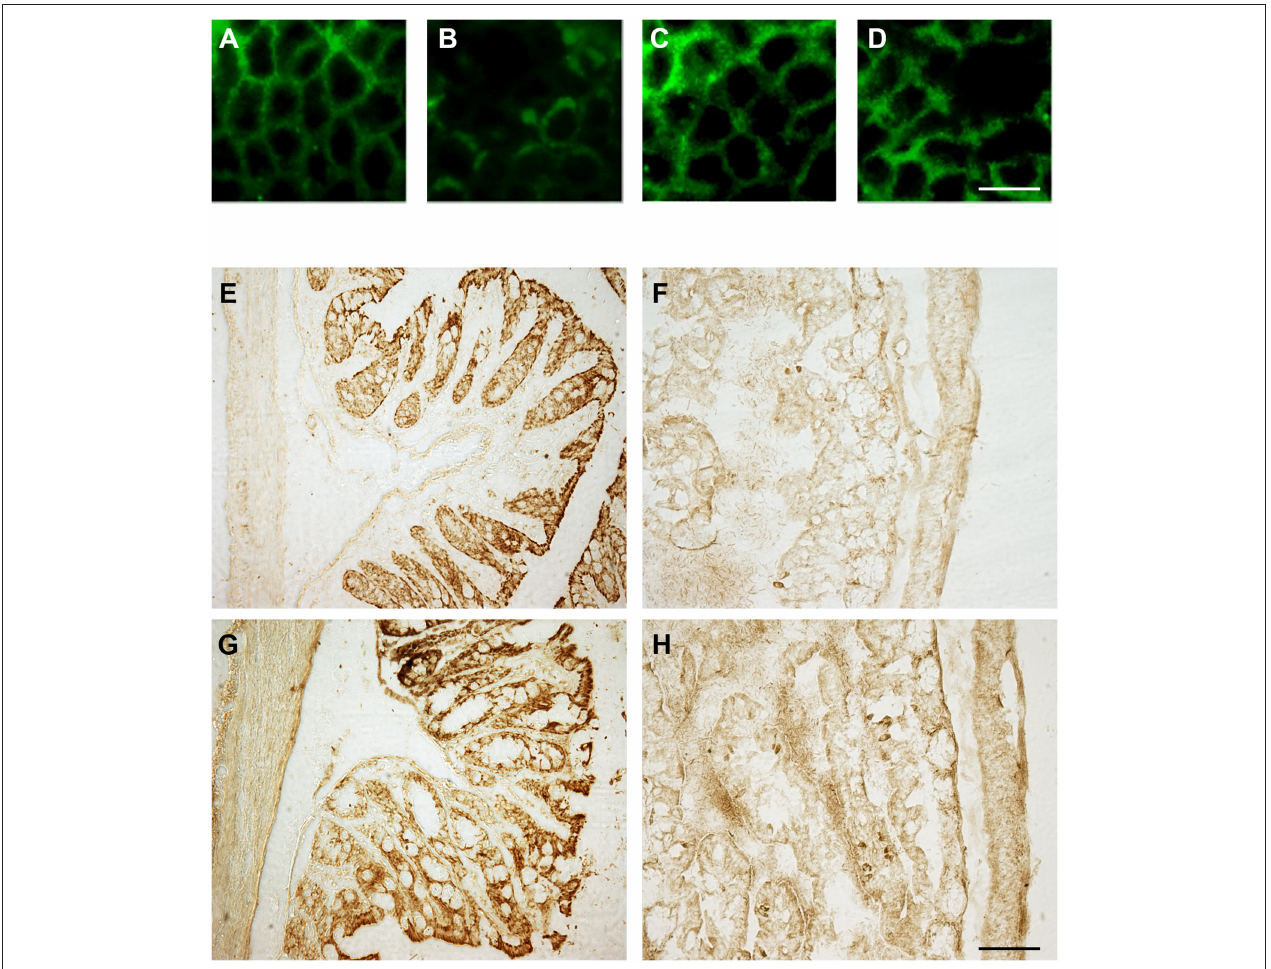
FIGURE 2 | OX-A preserves occludin immunoreactivity in Caco-2 cell monolayers as well as in sections of the small intestine after intraperitoneal administration. (A–D) Immunocytochemical staining of occludin (green signal) in Caco-2 cells treated with: LPS (6h; 0.5 µ g/ml) (B) ; OX-A (30min; 0.2 µ M) + LPS (6h; 0.5 µ g/ml) (C) ; SB334867 (15min; 10 µ M) + OX-A (30min; 0.2 µ M) + LPS (6h; 0.5 µ g/ml) (D) . Untreated cells are also shown (A) . (E–H) Occludin immunostaining of duodenal epithelial cells in mice treated with: vehicle (saline), (E) ; LPS (6h; 3.3 mg/kg) (F) ; OX-A (1h; 40 µ g/kg) + LPS (6h; 3.3 mg/kg) (G) ; SB334867 (30min; 30 mg/kg) + OX-A (1h; 40 µ g/kg) + LPS (6h; 3.3 mg/kg) (H) . Scale bar (A–D) : 20 µ m; (E–H) : 150 µ m.